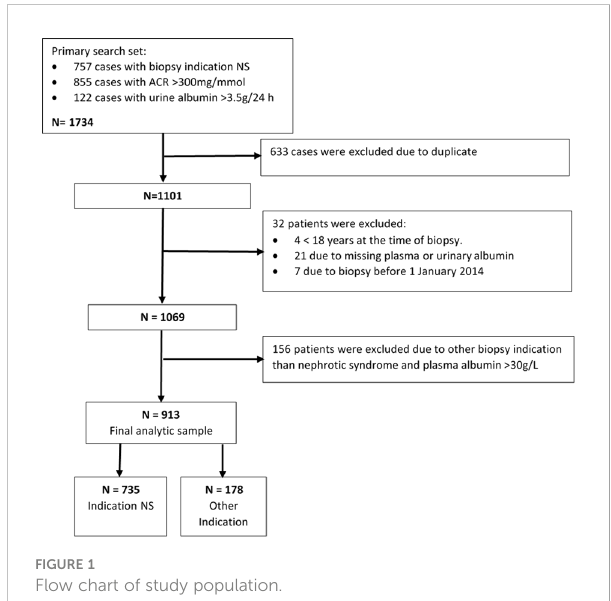
FIGURE 1 Flow chart of study